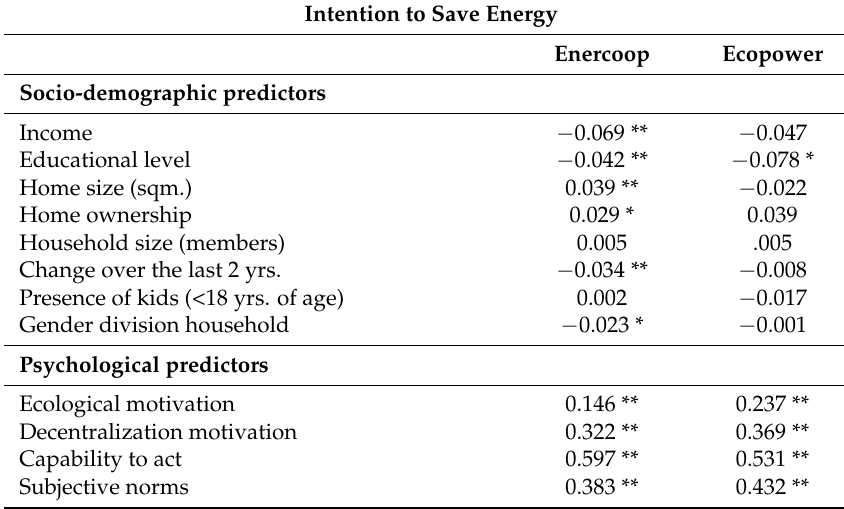
Table 5. Correlations for selected predictors and intention to save energy by REScoop